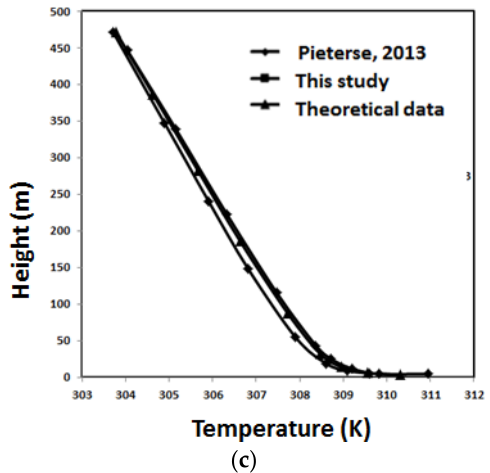
Figure 4. Inlet temperature vertical distribution comparisons against theoretical profiles ( a ) neutral condition, ( b ) stable condition, and ( c ) unstable condition.